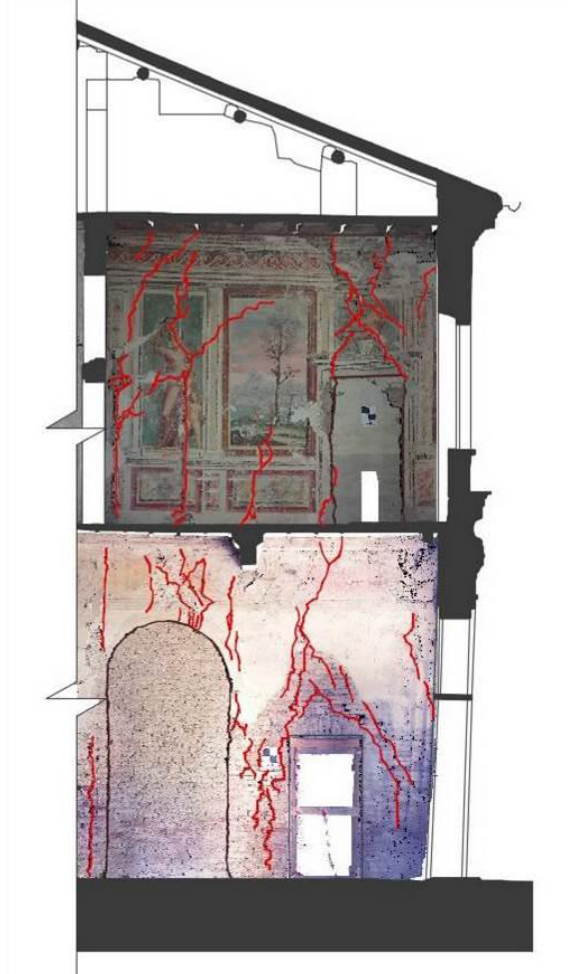
Figure 10: Details of the crack pattern.